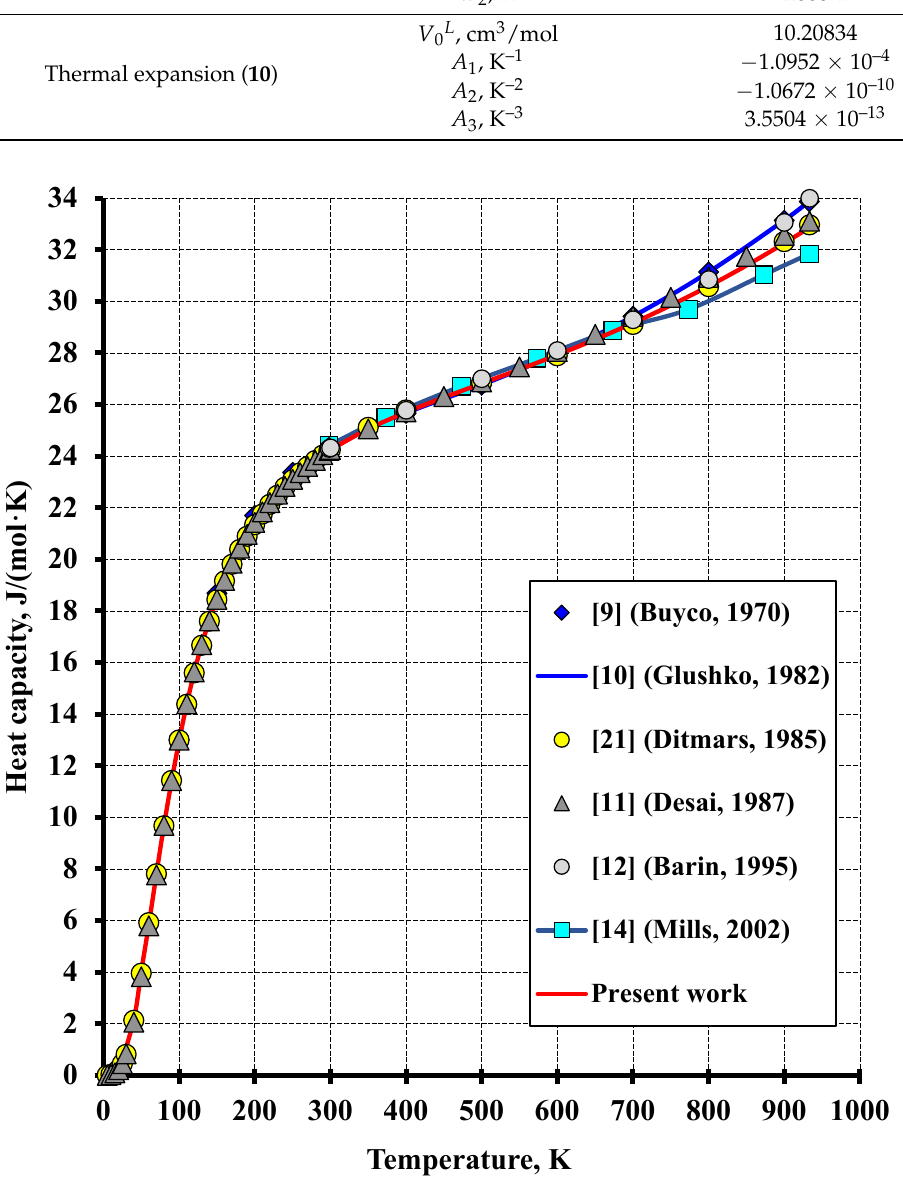
Figure 1. Isobaric heat capacity of solid aluminum. Figure 2 depicts the molar volume of solid aluminum plotted against temperature. The experimental data are fitted well by the calculated dependence. The mean absolute deviation was 0.0017 cm 3 /mol (RMS = 0.022%). The calculated molar volume at 298.15 K was 9.999 cm 3 /mol and is not different from the reference value. At 0 K, the calculated molar volume of 9.871 cm 3 /mol is distinct by 0.02% from that reported in [89].